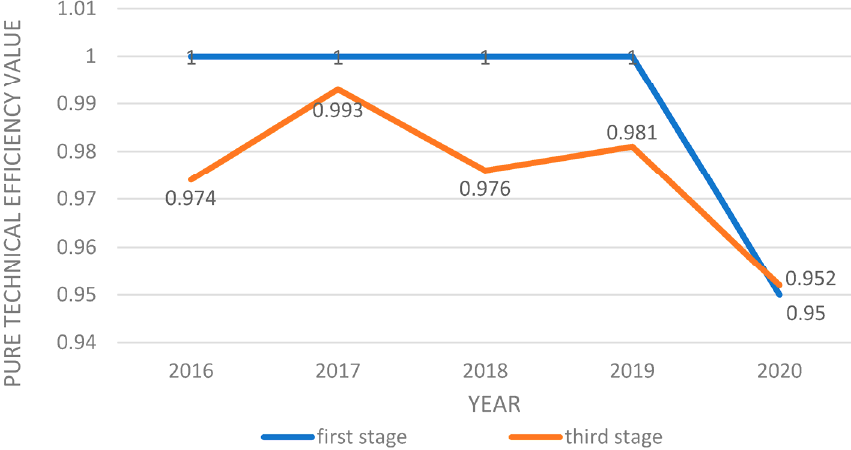
Figure 6. Pure Technical Efficiency Comparison of the Yangtze River Delta Port Groups.